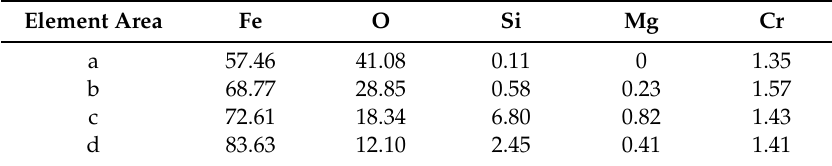
Figure 4. Optical image of LP before ( a ) and after ( b ) the tribological test. Figure 5 presents the Raman spectra of the worn surface of the friction pairs under the lubrication of LP and LP + 0.5 wt % NSPs. The intensity of the characteristic peaks of iron oxide [24] (676 cm −1 ) of the worn surface under the lubrication of LP + 0.5 wt % NSPs is lower than that under